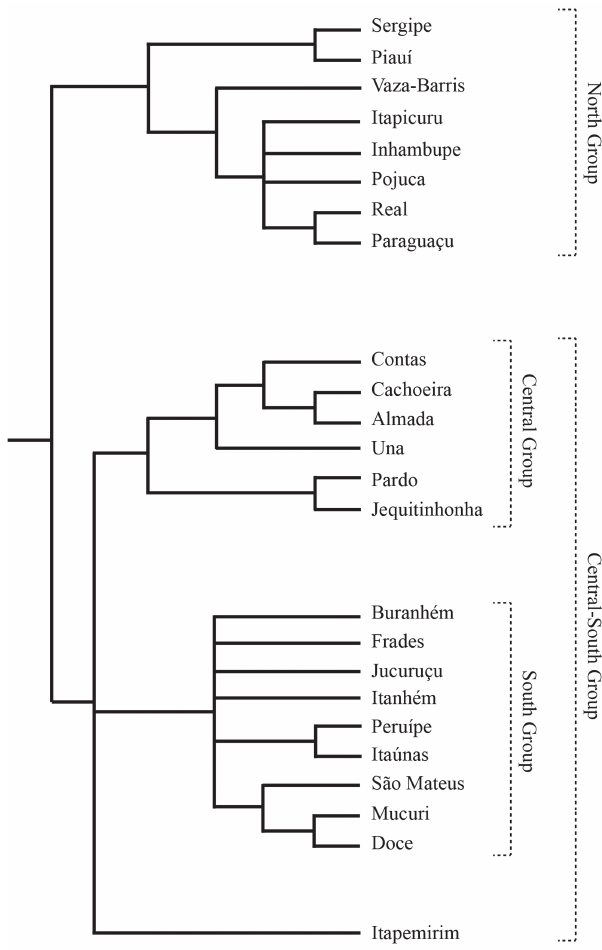
Fig. 2. Area diagram depicting relationships among the 24 coastal drainages analyzed, obtained by parsimony analysis of endemicity based on freshwater fishes. The topology represents the strict consensus of five equally parsimonious trees obtained through a heuristic search (length= 71 steps, CI = 0.521, RI =